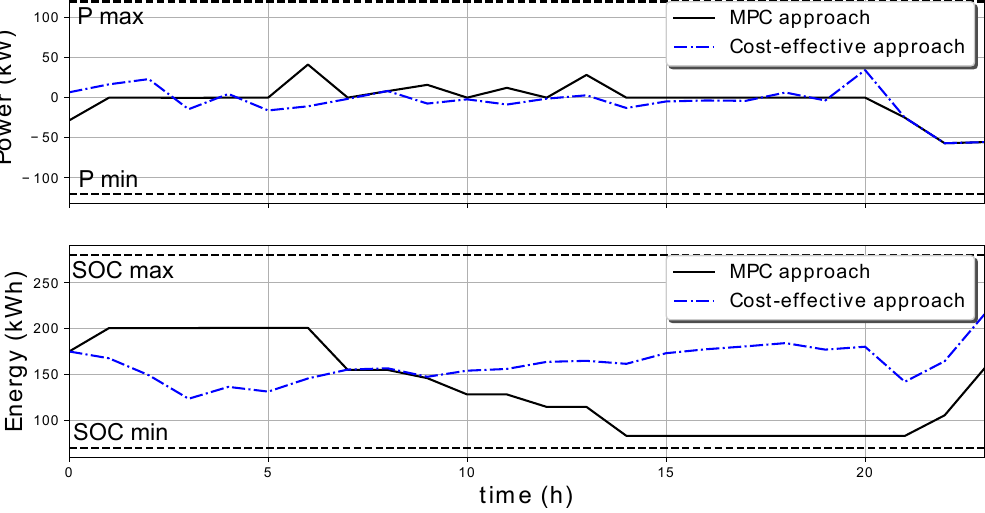
Figure 5. Optimal battery management for 24 h of operation for the two scenarios